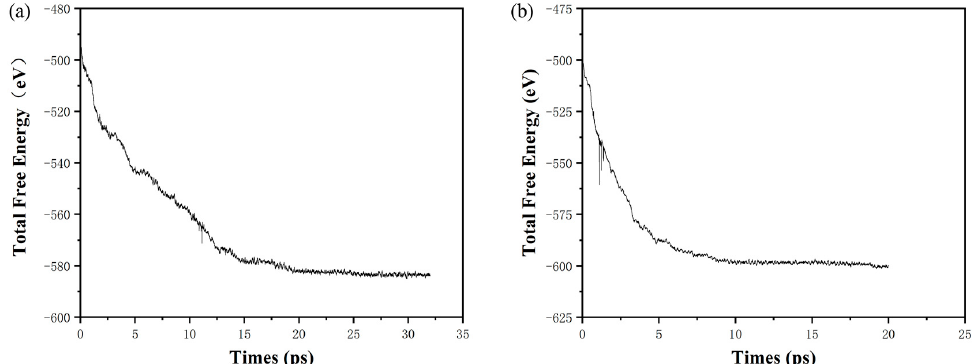
Figure 7. ( a ) Change of Helmholtz free energy of nano Al/CuO energetic composite films with a one-modulation-period configuration during the preparation process. ( b ) Change of free energy of Helmholtz nano Al/CuO energetic composite films with a two-modulation-period configuration during the preparation